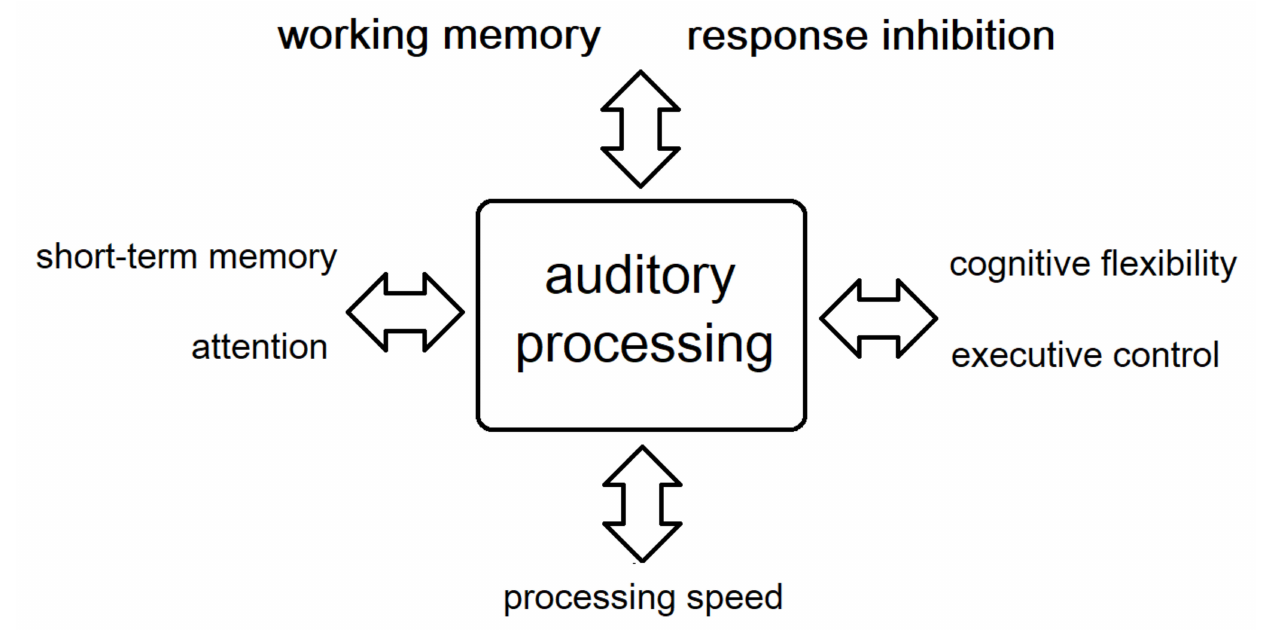
Figure 1. Correlations between auditory processing and cognitive functions.